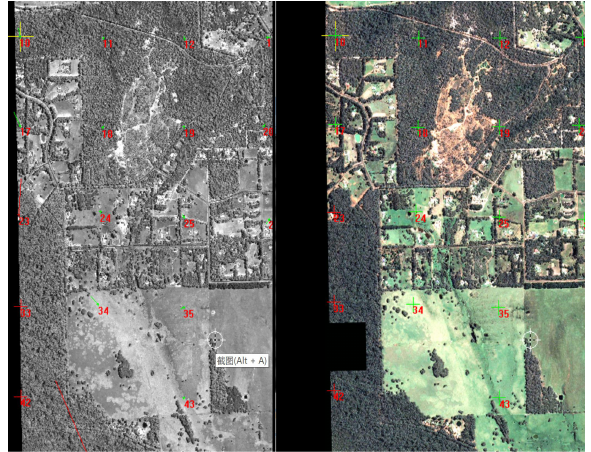
Figure 2. Image matching point distribution